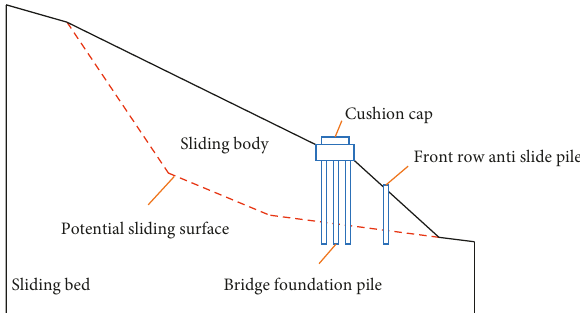
Figure 15: Reinforcement type of the front antislide pile of the bridge foundation located in the antislide